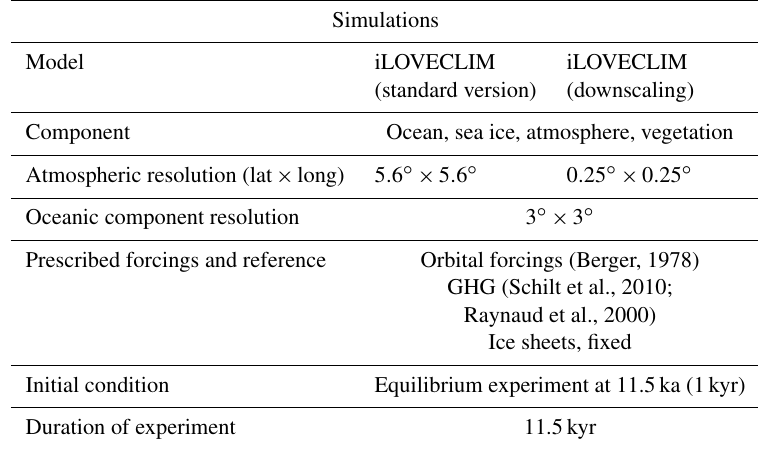
Figure 2. Climate forcings used in the experiment GHG forcings (Raynaud et al., 2000) and summer (July) insolation at 65 ◦ N during the Holocene (Berger, 1978). Table 1. Summary of the main features of the model and experimental